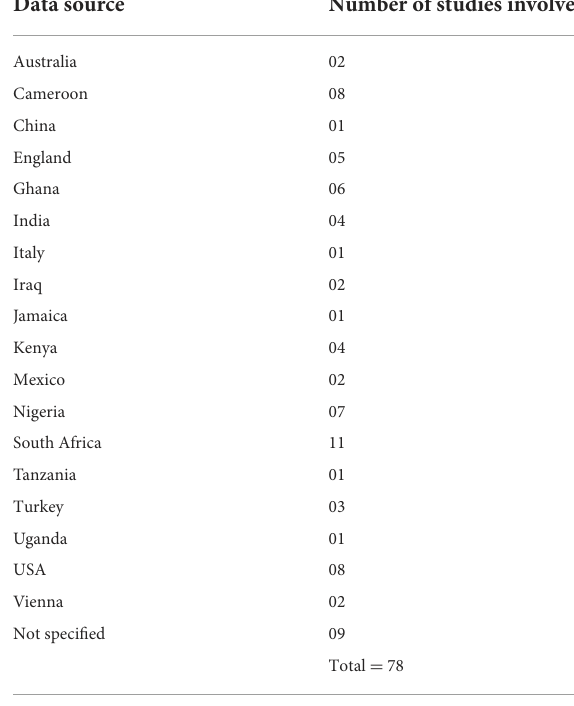
TABLE 1 Chemical composition of pure kaolin. TABLE 2 Source and number of published data related to